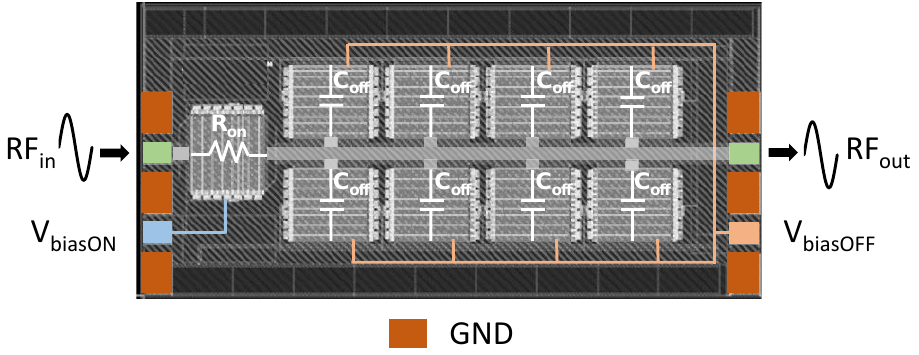
Figure 8. Layout of SP9T switch test structure showing the individual contact terminals in the GSGSG configuration for probing with the ON or OFF state of each branch represented by R on or C off , respectively.